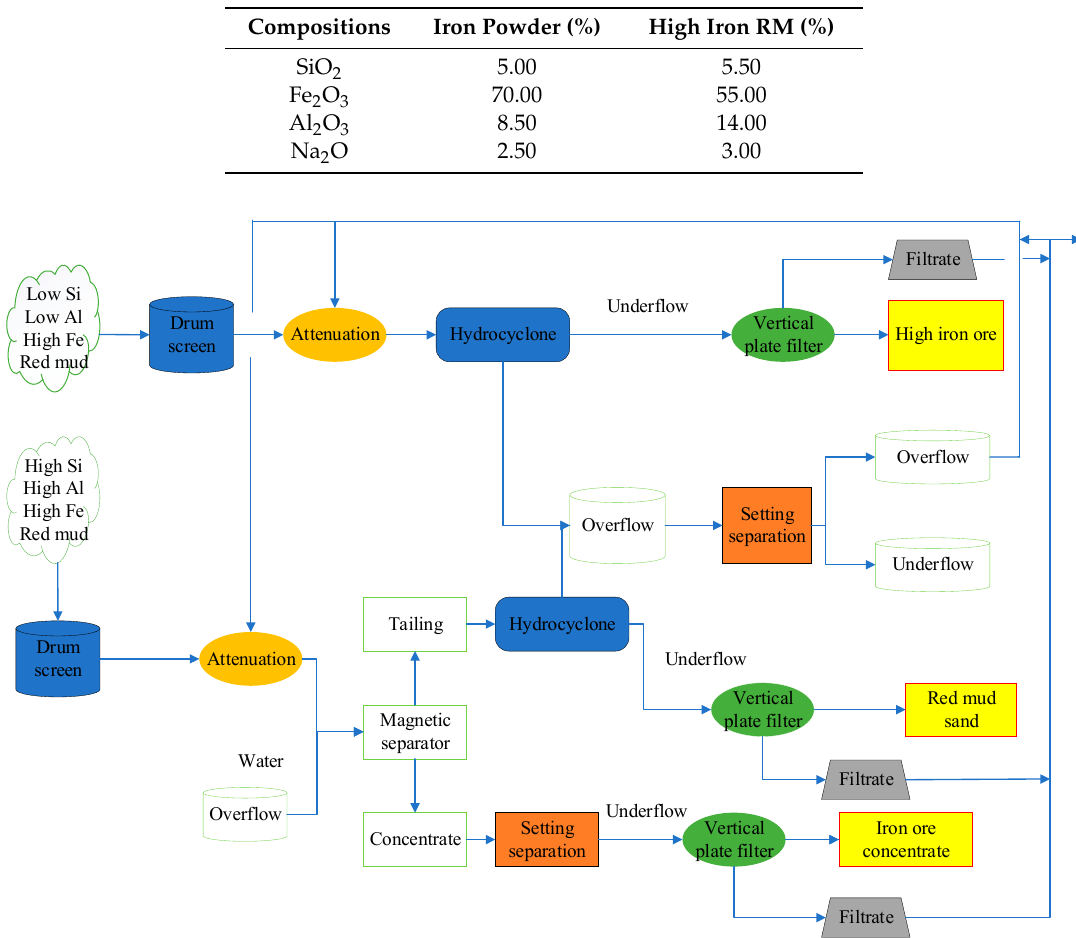
Figure 11. Iron separation from Bayer RM used in Shandong Aluminum Company [111]. Table 7. Compositions of iron powder and high iron RM from Bayer RM.